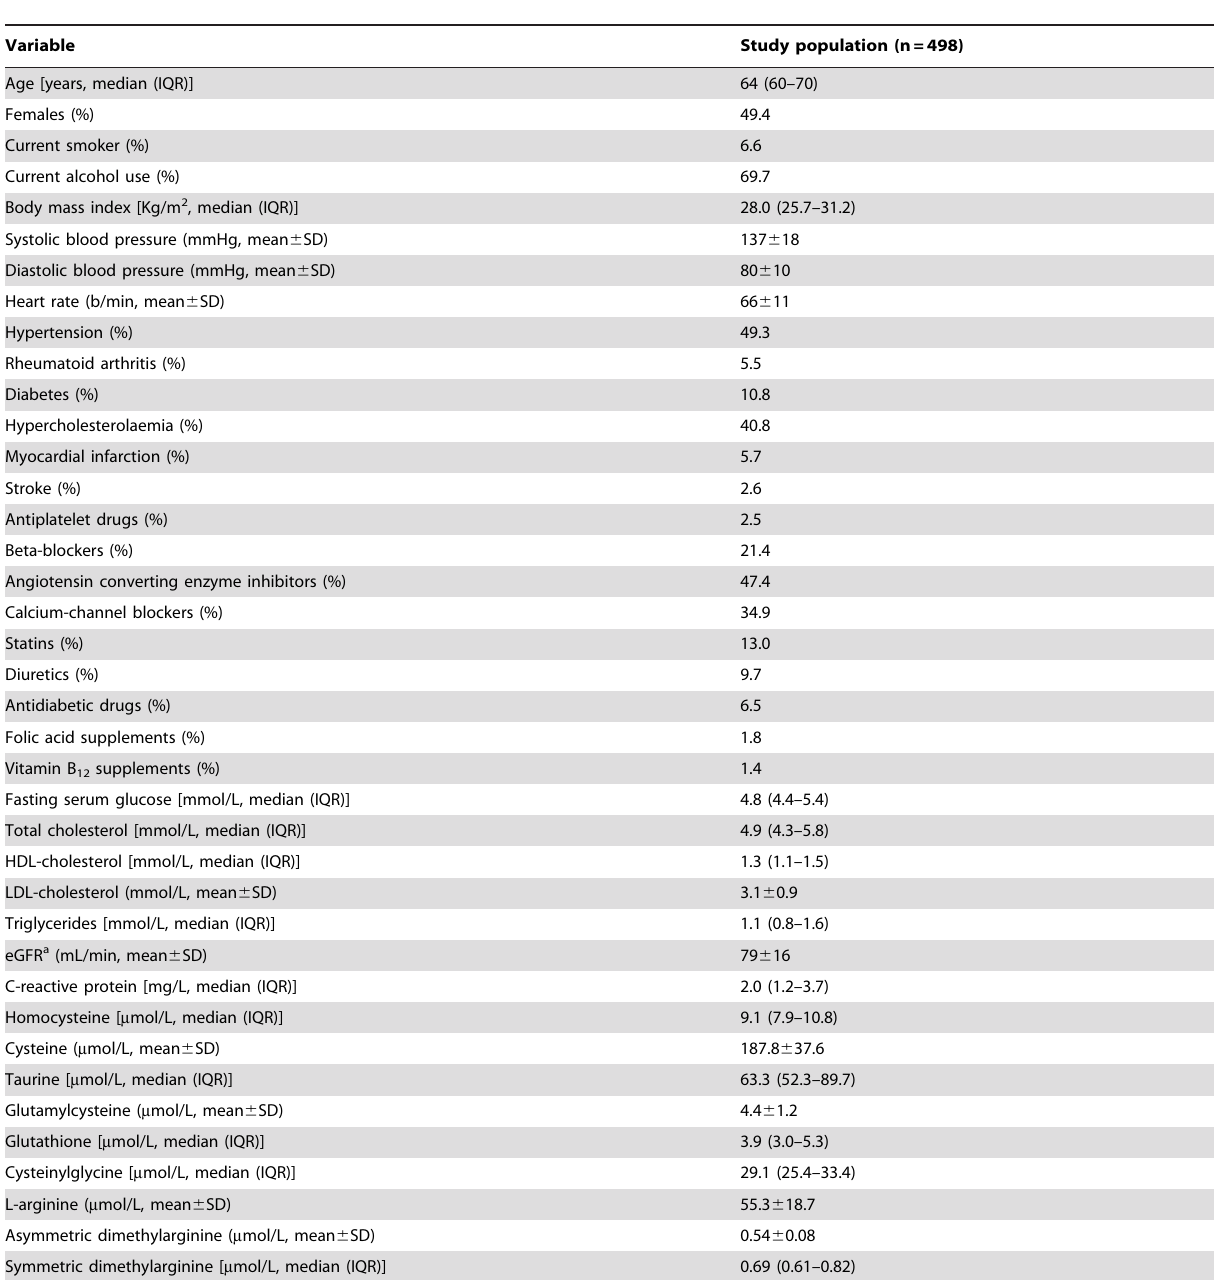
Table 1. Clinical, demographic, biochemical characteristics and medication